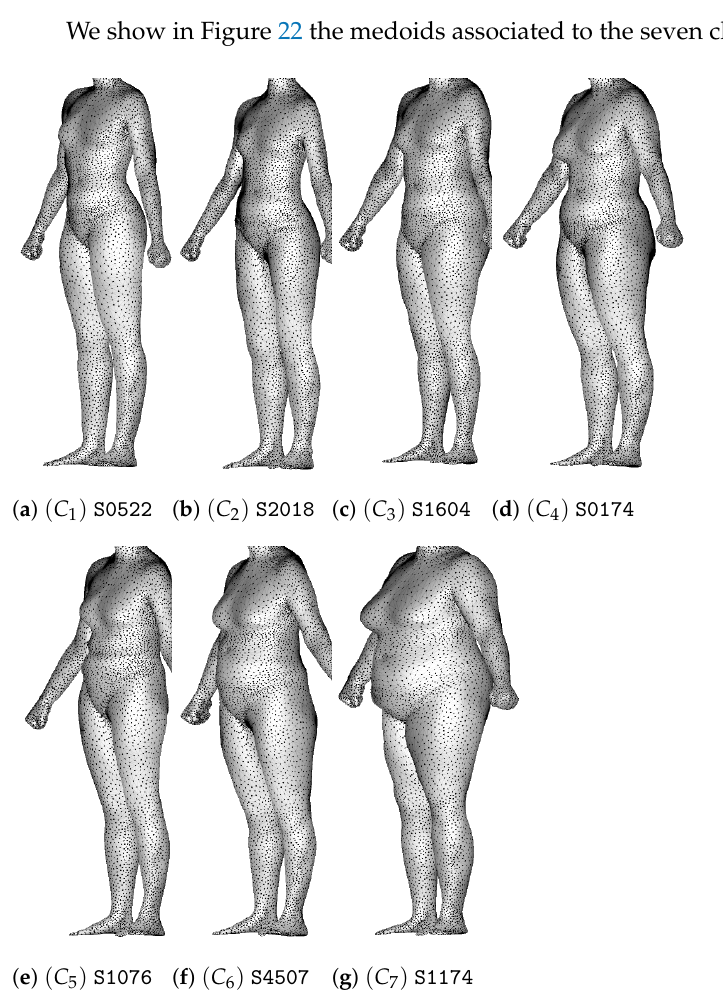
Figure 22. Medoids of the seven clusters of the Ward-linkage hierarchical